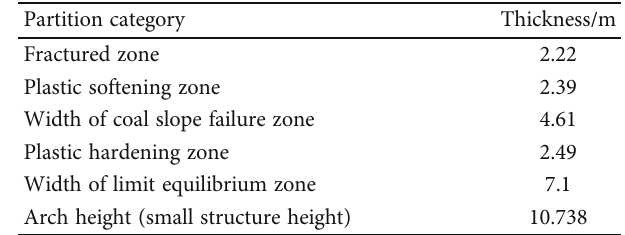
Table 1: Partition and stress arch height of coal pillar in transportation